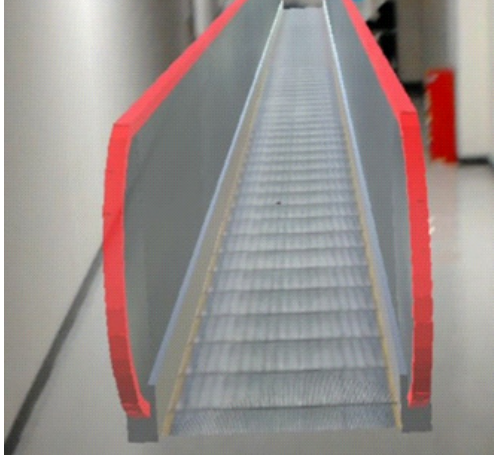
Figure 16. Appearance of AR moving walkway texture on the corridor.